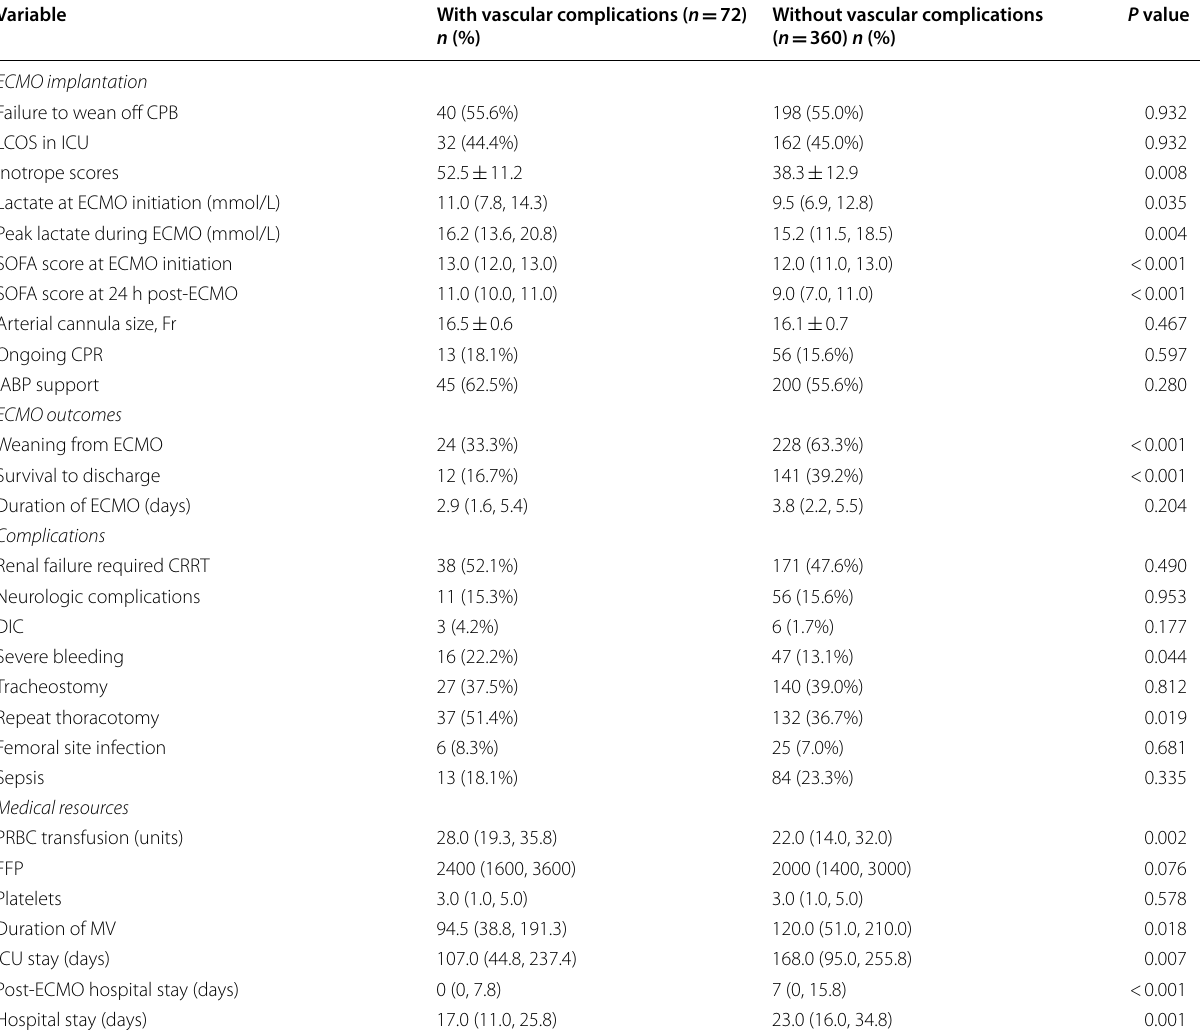
Table 2 ECMO details and